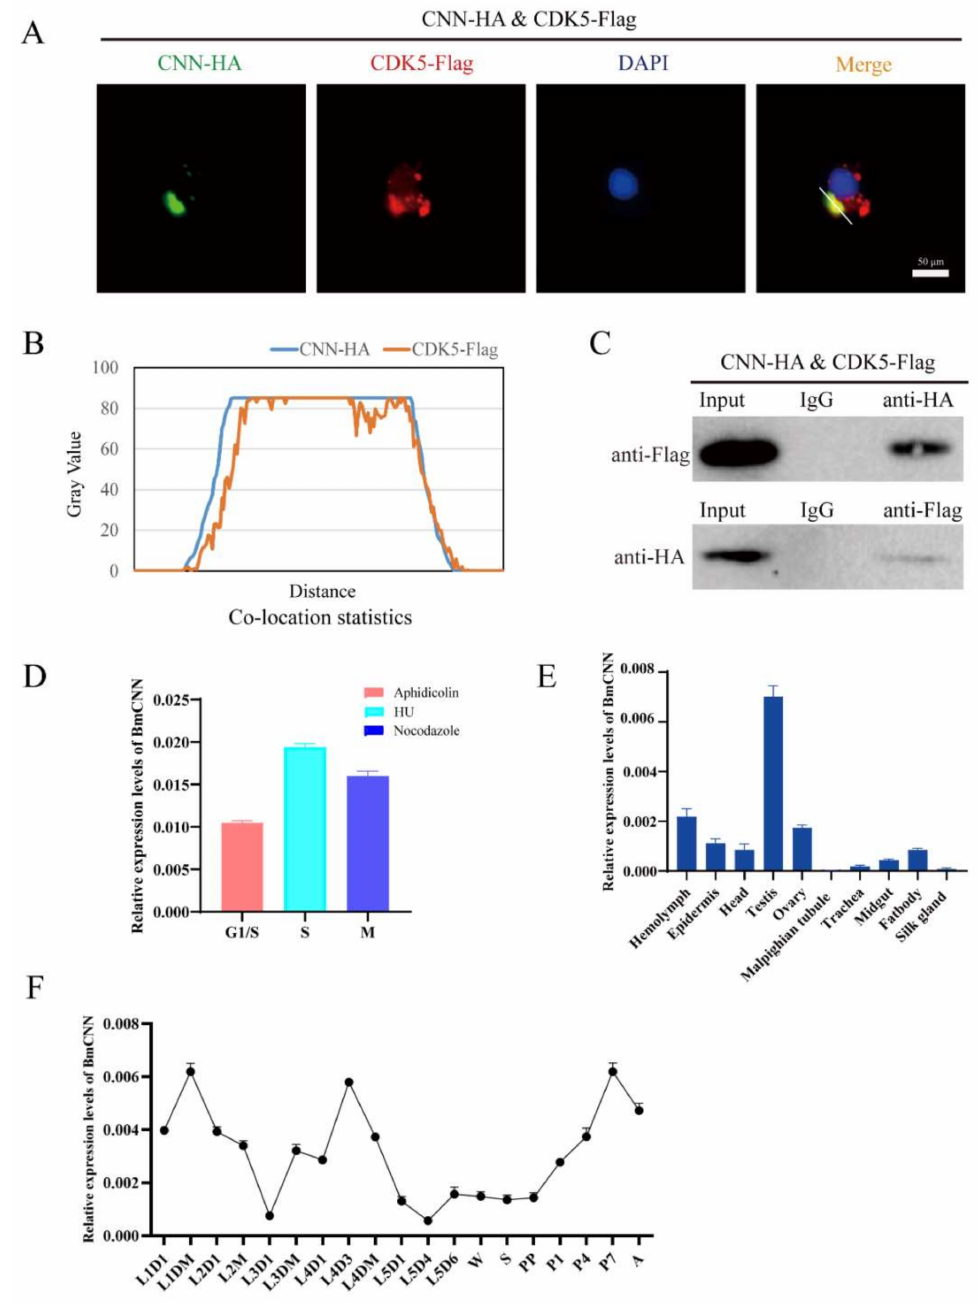
Figure 5. Interaction of BmCDK5 and BmCNN. ( A ) The co-localization of BmCNN (green) with BmCDK5 (red) using IF analysis. ( B ) The statistics analysis of IF co-localization. ( C ) The interaction of BmCDK5 and BmCNN by Co-IP assays. ( D ) The expression pattern of BmCNN in different phase of the cell cycle in BmNS cells. ( E ) The expression pattern of BmCNN in different tissues of B. mori in fifth instar larvae. ( F ) The expression pattern of BmCNN in different development stages of B. mori